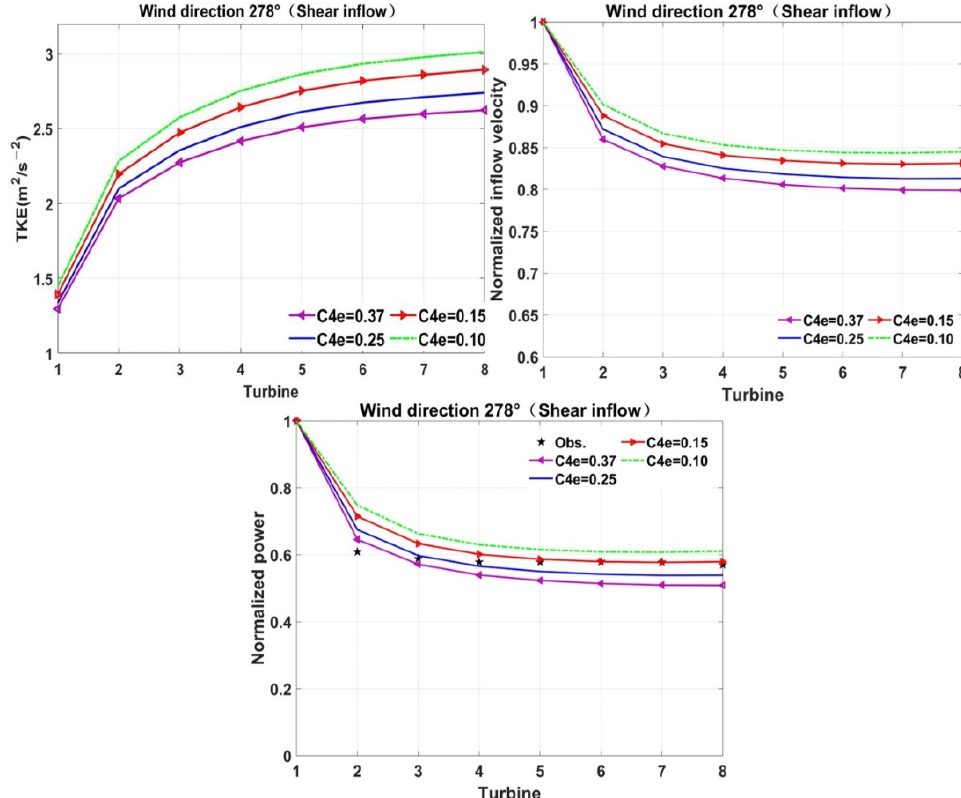
Figure 19. Effects of different C 4 ε values on TKE, inflow wind speed and power output under shear inflow conditions when the incoming wind direction is 278° and the undisturbed inlet velocity is 10 m/s.